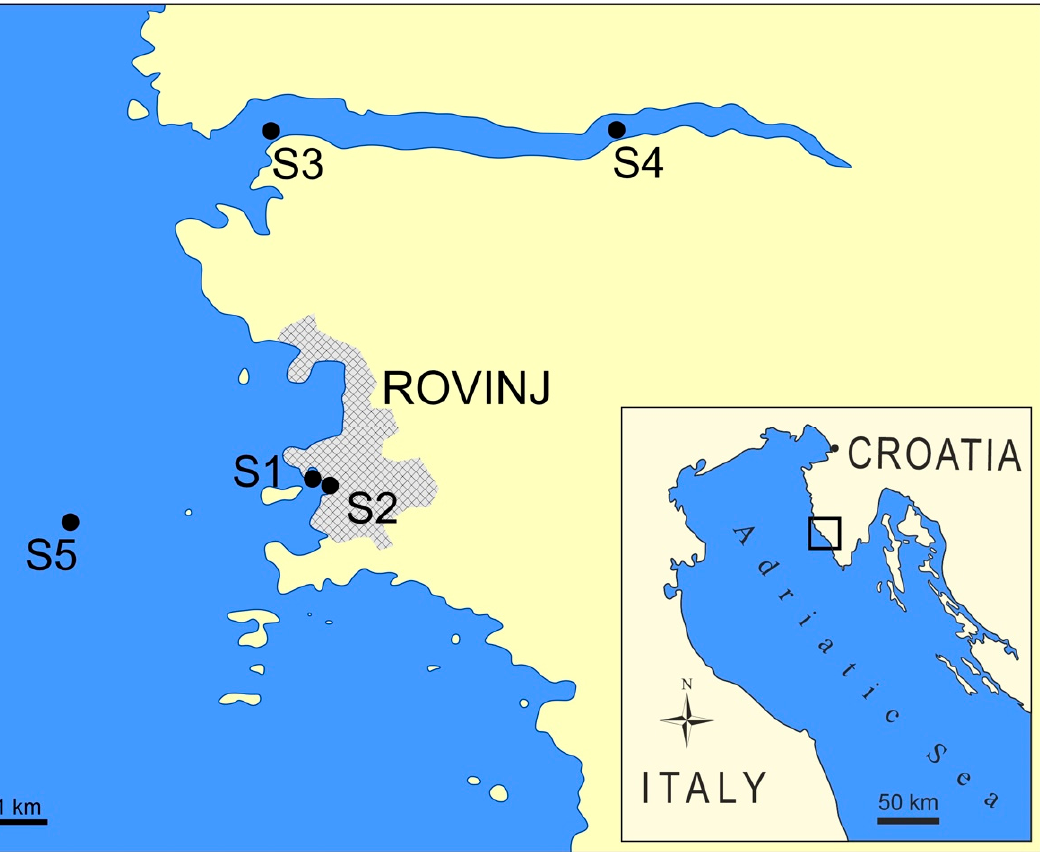
Figure 1. Location of the sampling sites in NE Adriatic Sea: S1—Local harbour, S2—Shipyard, S3—Lim Bay out, S4—Lim Bay middle and S5—Open sea (3 NM in front of Rovinj city).